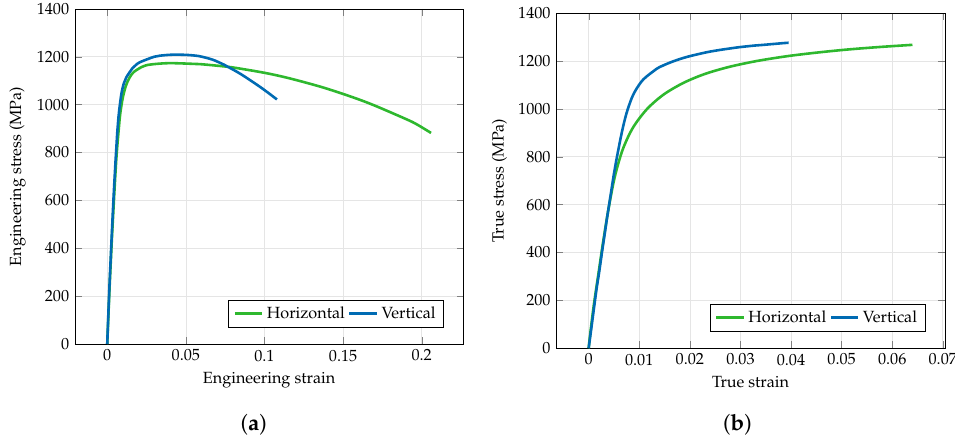
Figure 5. Monotonic tensile test results for the deposited 18Ni300 specimens: engineering stress- engineering-strain curves ( a ) and true stress–true strain ( b )